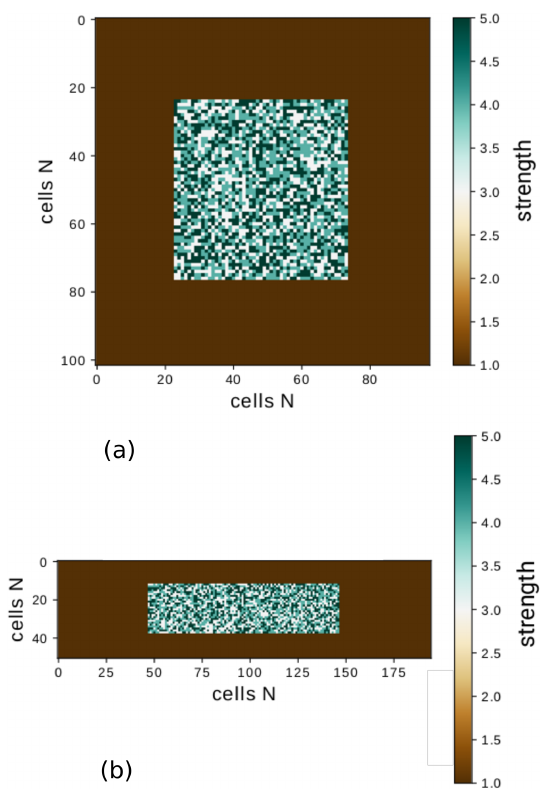
Figure 10. Example of two sub-seismic regions with different as- pect ratio, χ = L eff /W eff . The number of cells remains constant in both cases N cell = 10000. (a) R a = 1 and χ = 1 . 0, (b) R a = 2 and χ = 3 .